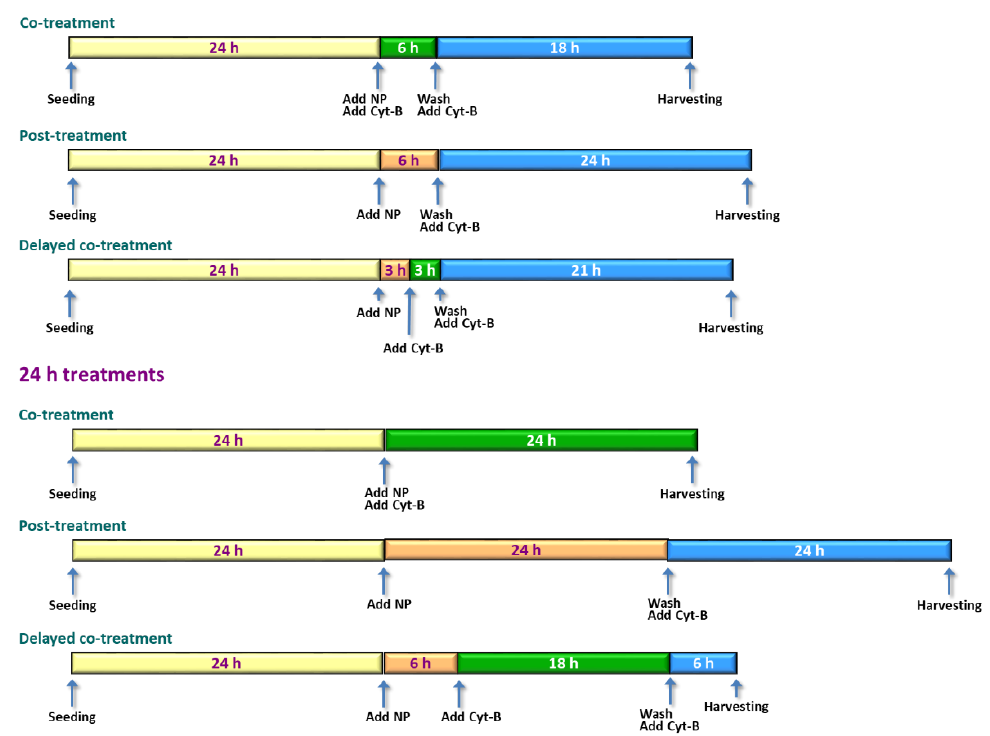
Figure 1. Scheme showing the chronology of CBMN test experiments. Exposure of the cells to TiO 2 NP was conducted for 6 and 24 h following three different treatment variants: co-treatment, post-treatment, and delayed co-treatment. Color code: yellow: no treatment; orange: treatment with NP; blue: treatment with Cyt-B; green: treatment with NP + Cyt-B.